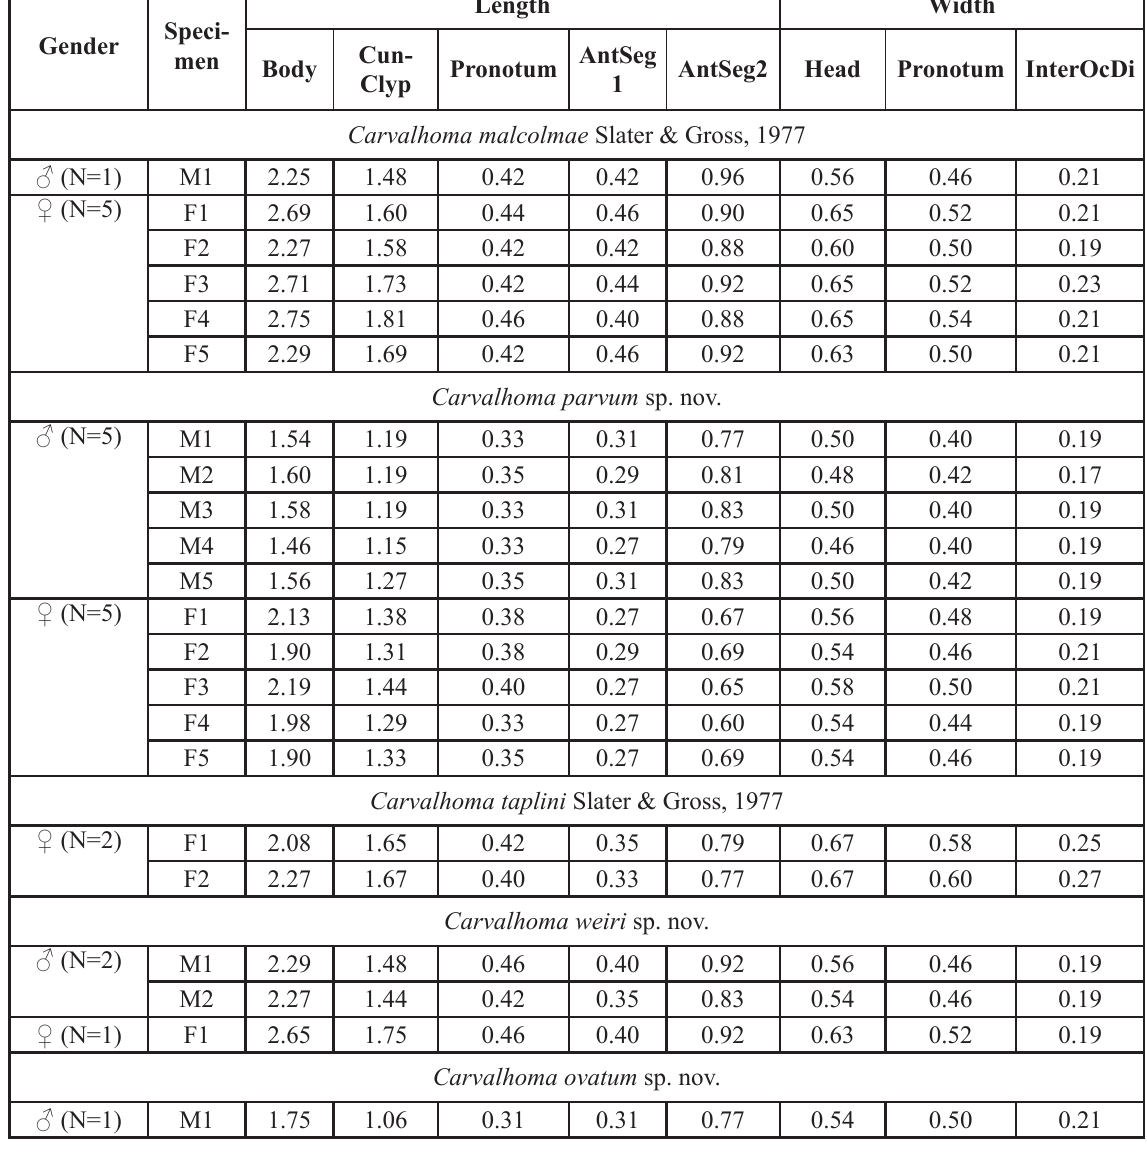
Table 1. Measurements. Abbreviations: Cunclyp = the length between apex of clavus and the base of clypeus; AntSeg = the antennal segment; InterOcDi = the vertex